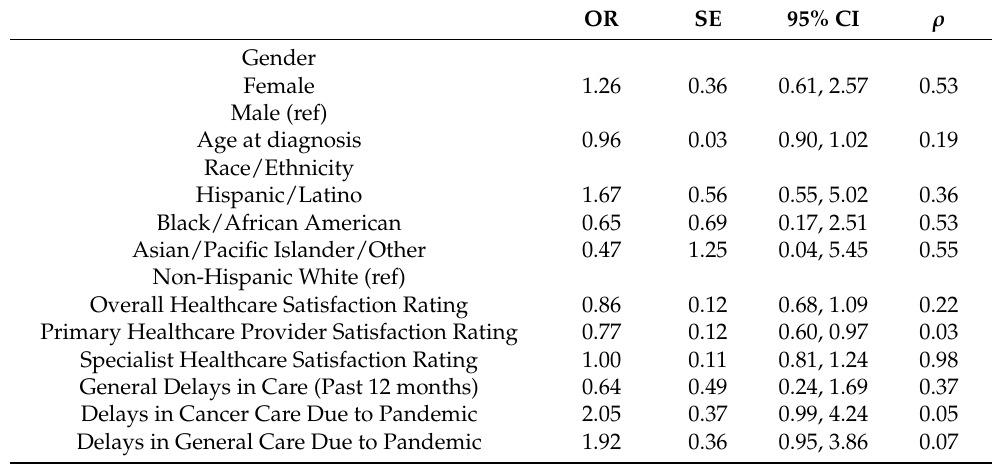
Table 2. Multivariable regression of ER super-utilization (>4 visits) and patient care